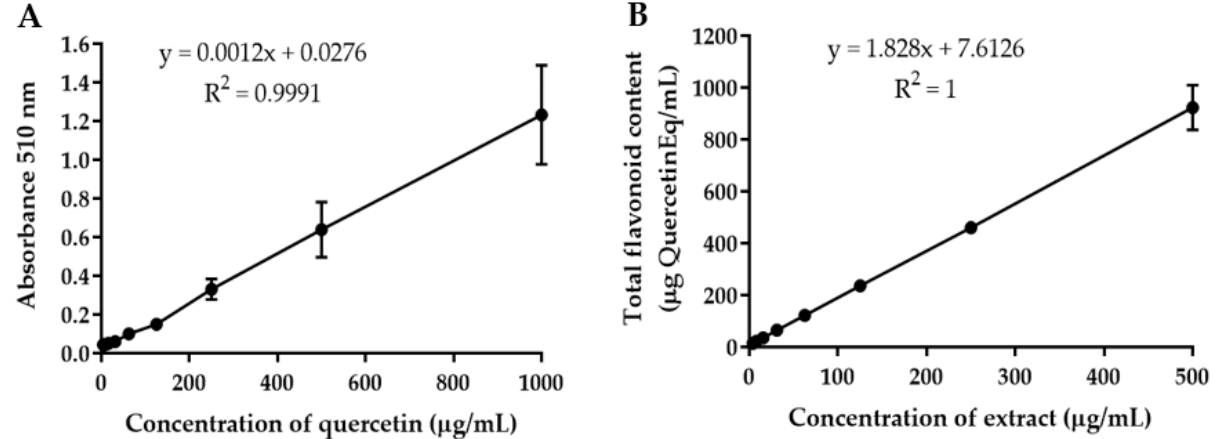
Figure 2. ( A ) Calibration curve of quercetin. ( B ) Total flavonoid content of B. flabellifer male flower ethanolic extract.